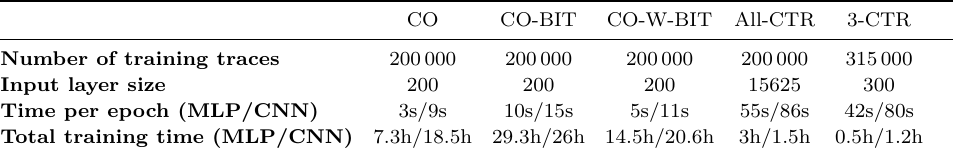
Table 3: Training times